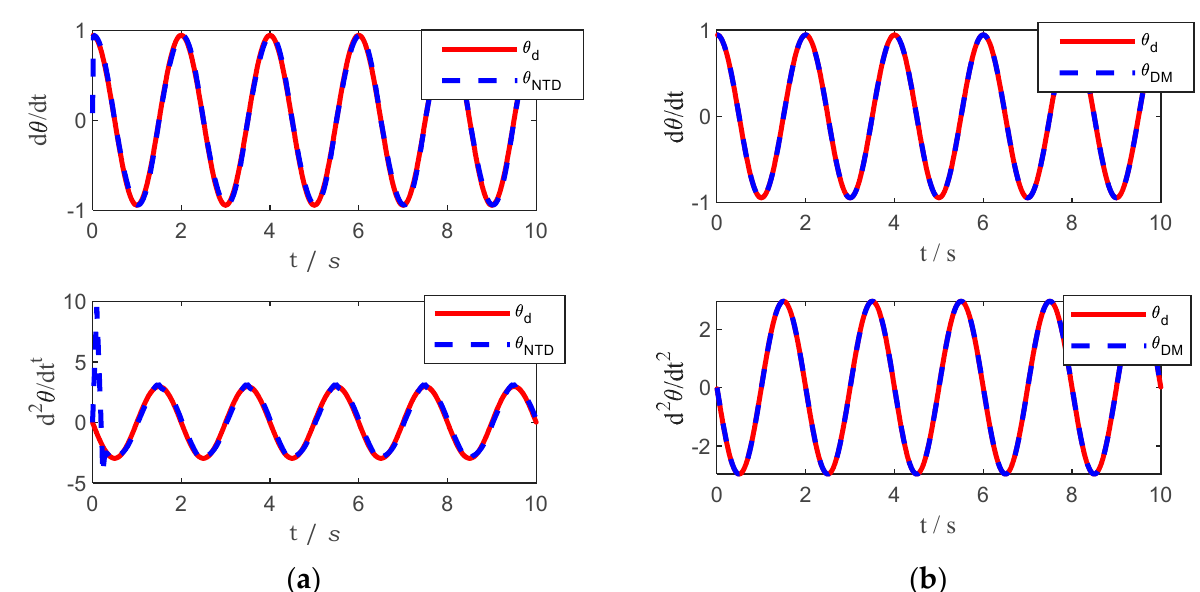
Figure 4. Trajectory (noise-free) tracking results by using different method. ( a ) Trajectory tracking by using nonlinear tracking differentiator. ( b ) Trajectory tracking by using the difference method.